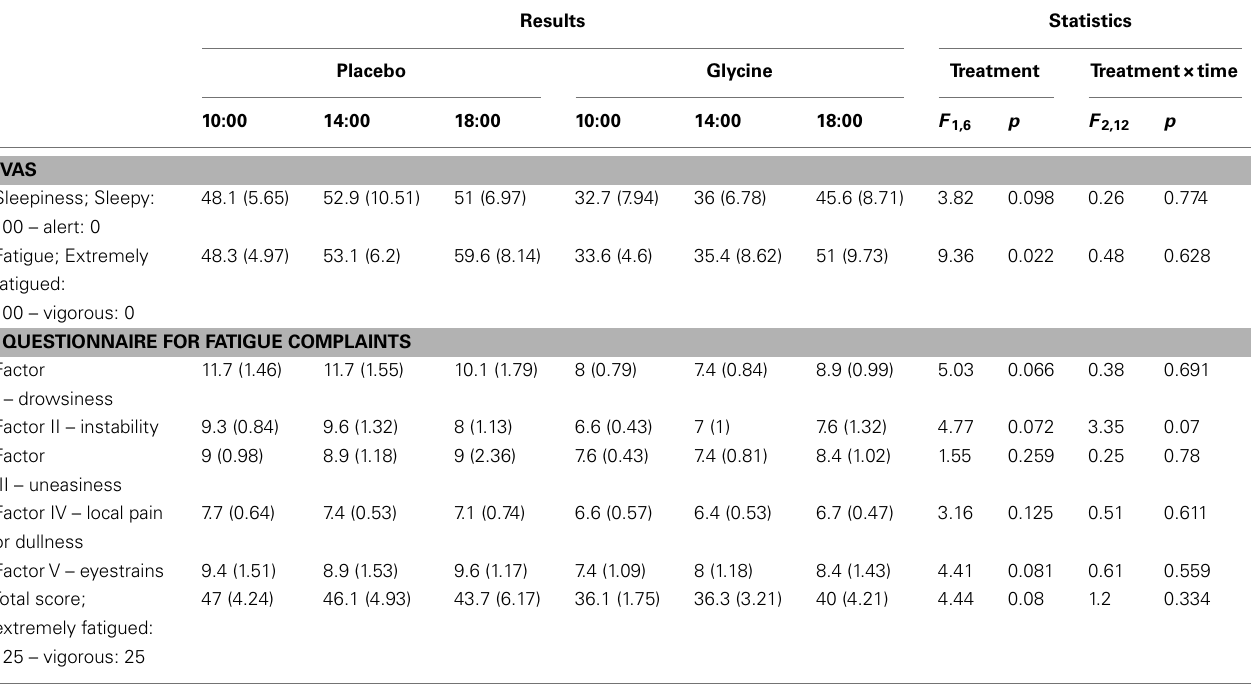
Table 1 | Results and statistics forVAS and the questionnaire for fatigue complaints on day